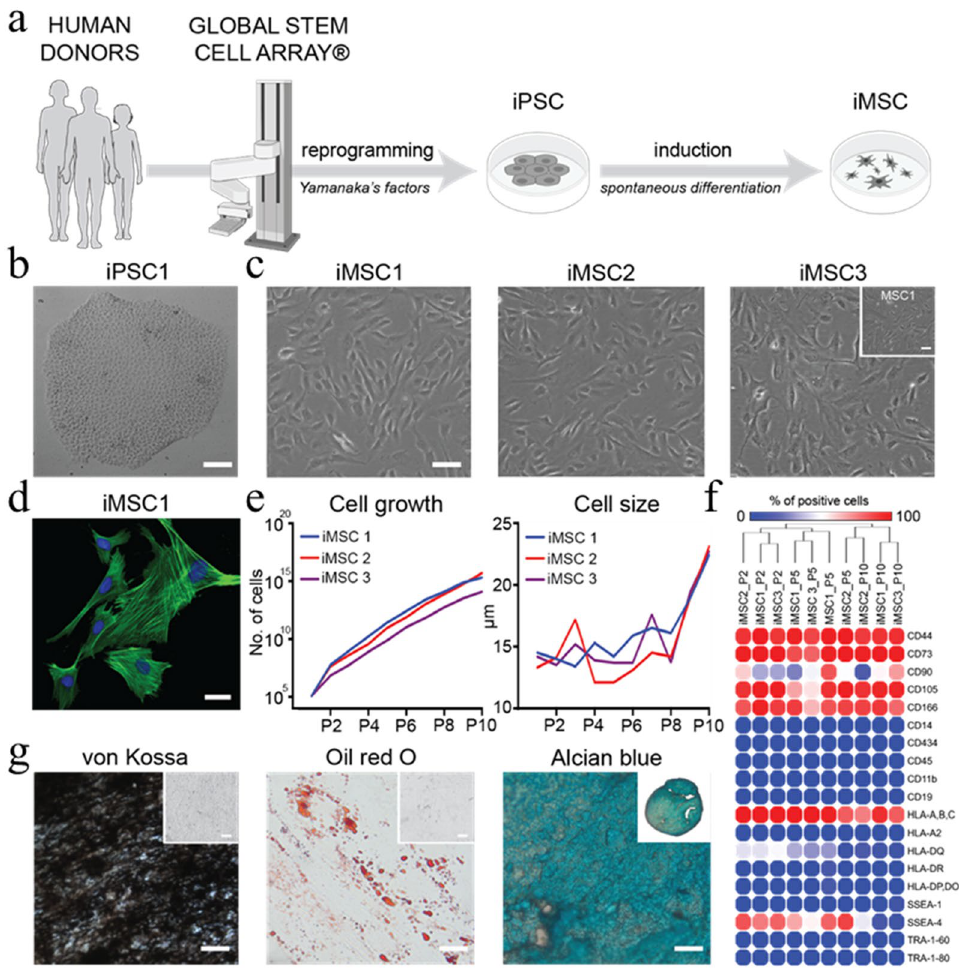
Figure 1. Derivation and characterization of human iMSC lines. ( a ) Schematic of automated reprogramming of human fibroblasts into iPSC lines using a NYSCF Global Stem Cell Array ® . ( b ) Representative brightfield image of iPSC colony generated using automated platform. Scale bar, 100 µm. ( c ) Representative brightfield images of iMSC lines derived from three different donors at passage 5. Inset shows commercially available bone marrow derived MSCs at passage 5. Scale bar, 50 µm. ( d ) Representative confocal image of iMSCs stained for actin (green) and nuclei (blue). Scale bar, 20 µm. ( e ) Plots of cell growth and average cell length for 3 iMSC lines over 10 passages. ( f ) Hierarchical clustering of surface marker screening data for 3 iMSC lines at passage 2, 5, and 10 and MSCs at passage 5. ( g ) Representative brightfield images of iMSCs (line 1) differentiated towards osteogenic (von Kossa), adipogenic (Oil Red O), and chondrogenic (Alcian blue) tissues. Insets represent negative controls and full-size cartilage spheroids. Scale bar, 20